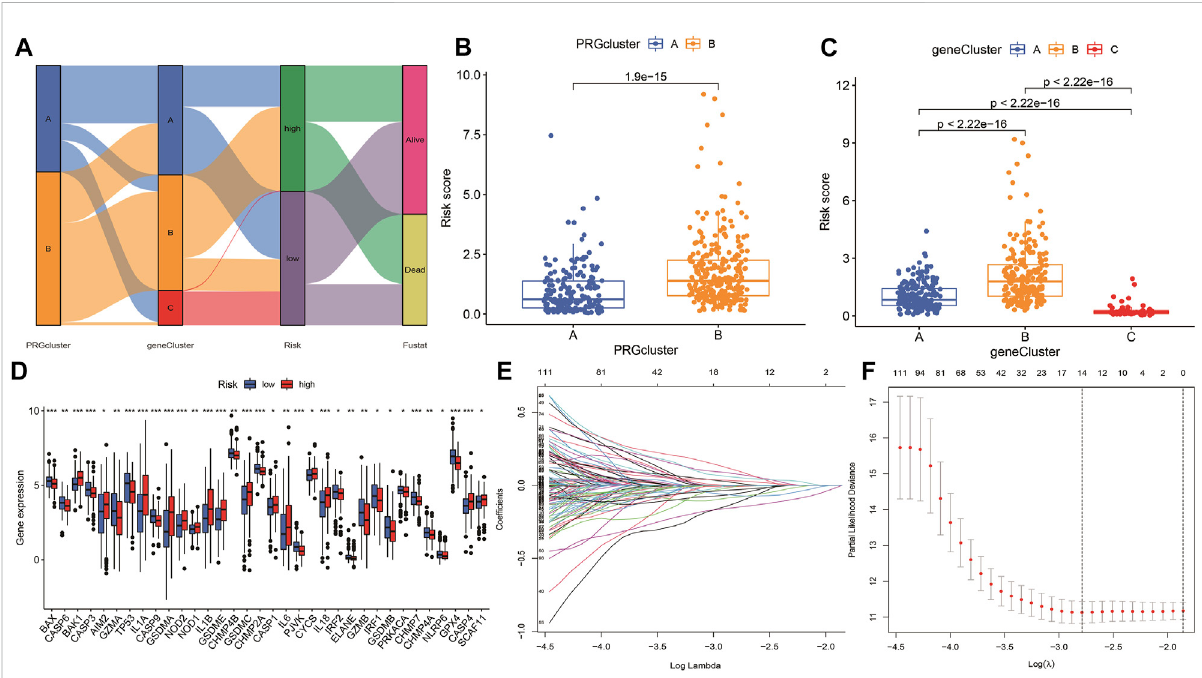
FIGURE 7 Alluvial diagram showing the changes of risk, clusters, and fustat. (A) The changes in clusters, risk, and fustat shown in Alluvial diagram. (B) The risk scores of pyroptosis were compared between the two PRG groups. Blue box representation cluster A, orange box representation cluster B. (C) The risk scores of pyroptosis in three gene clusters were compared. The blue box represents cluster A, the orange box represents cluster B, and the green box represents cluster C. (D) LASSO regression in 34 PRGs. (E) LASSO regression of prognostic genes (F) cross-validation of LASSO regression.